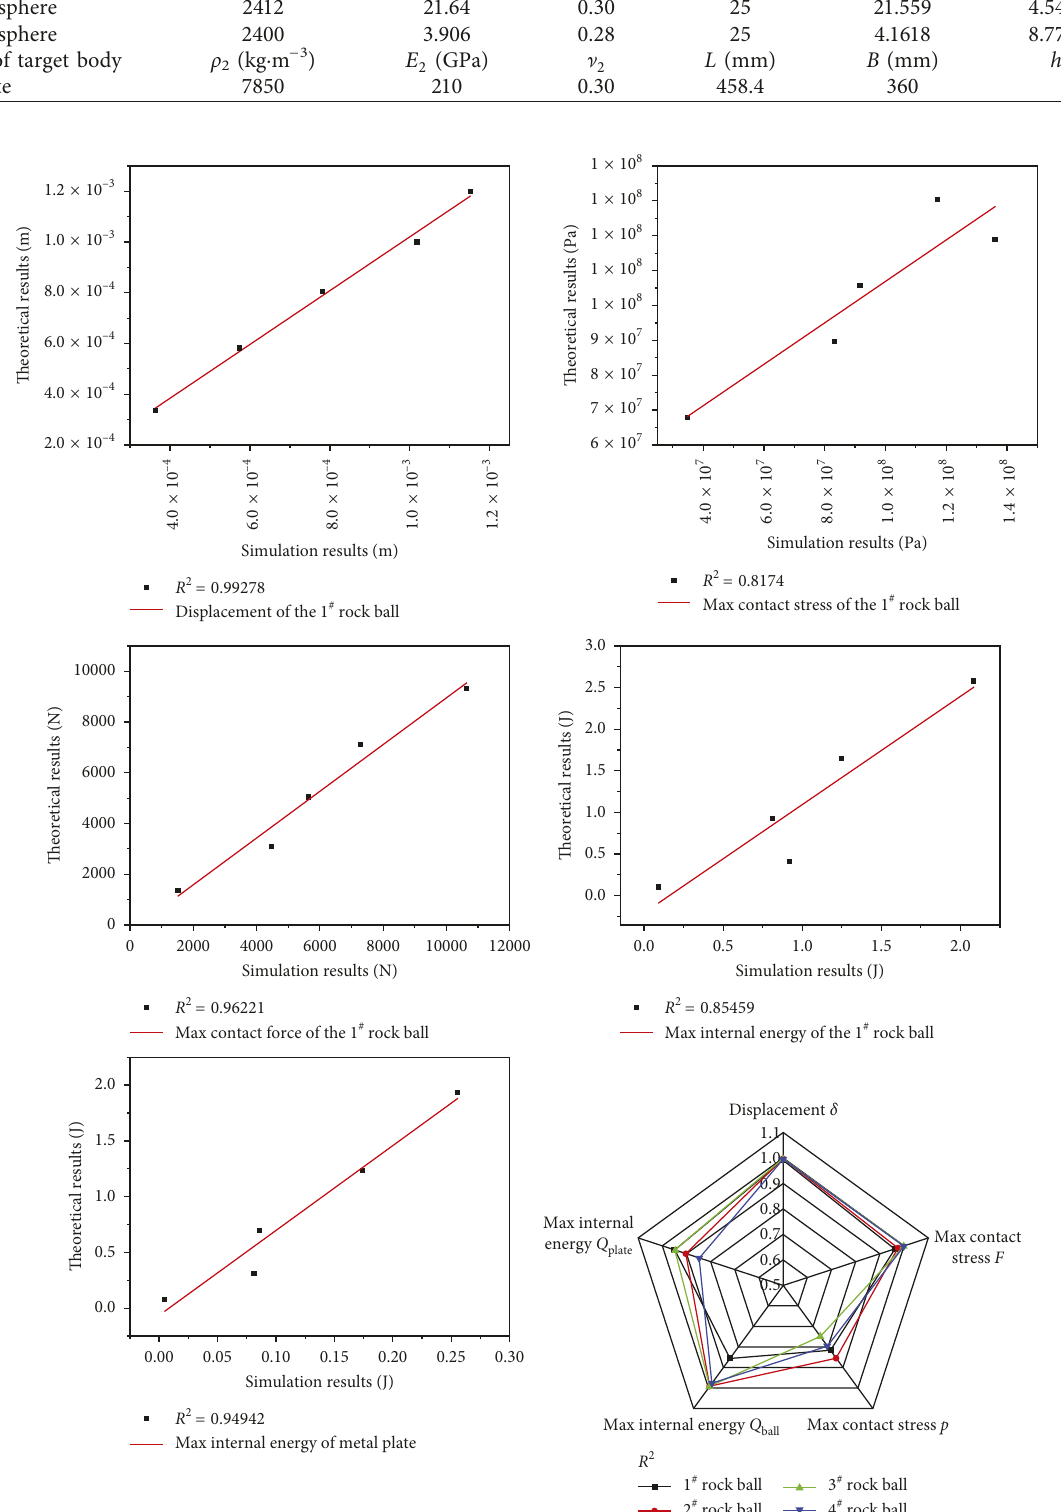
Figure 9: The relationship between the simulated values and theoretical values (take 1 # material as an example).